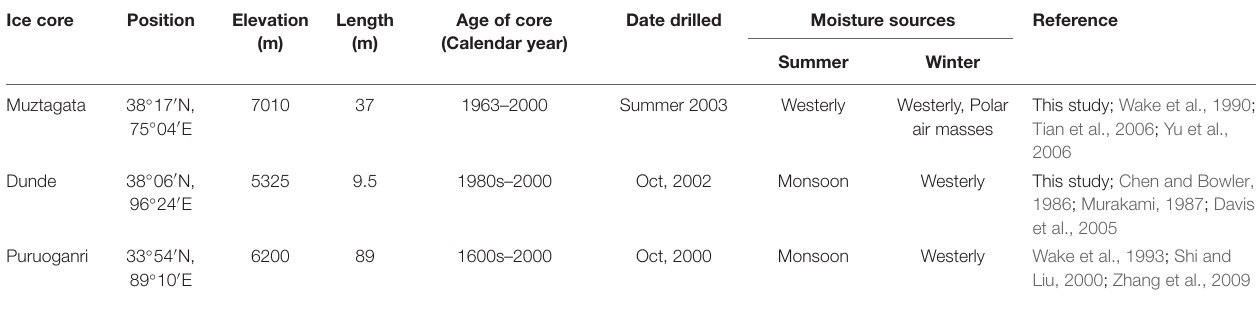
TABLE 1 | Ice core location and